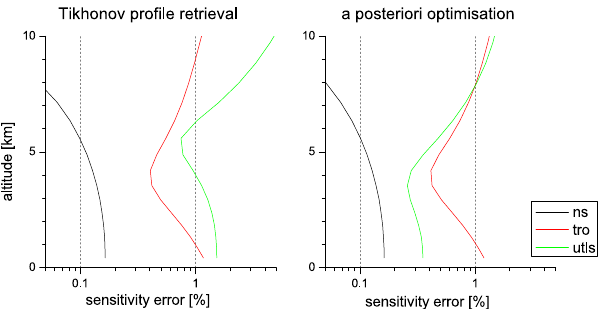
Figure 5. Estimated sensitivity errors for CH 4 for local surface small-scale variability (black line), tropospheric variability (red line), and variability in the UTLS due to a tropopause altitude shift (green line). Left panel: for the Tikhonov–Phillips profile retrieval. Right panel: after applying the a posteriori